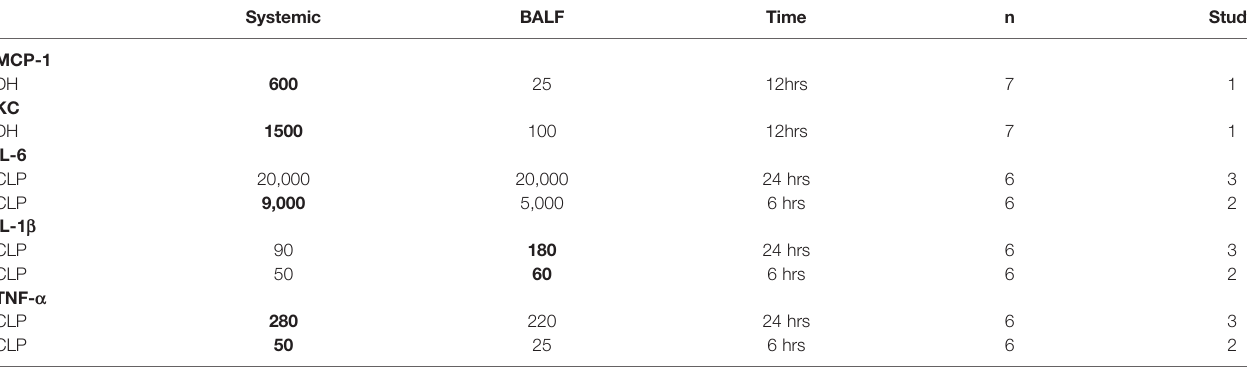
TABLE 4 | Systemic and bronchoalveolar lavage fl uid (BALF) cytokines in animal models of indirect lung injury.